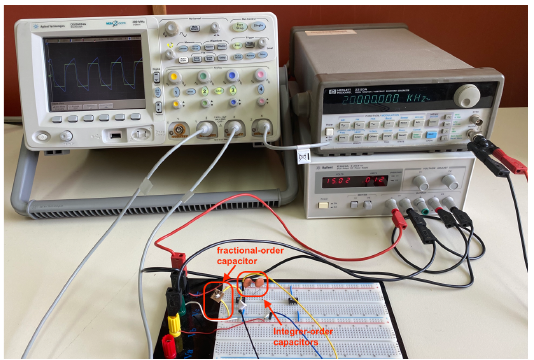
Figure 6. Experimental setup for evaluating the performance of the proposed